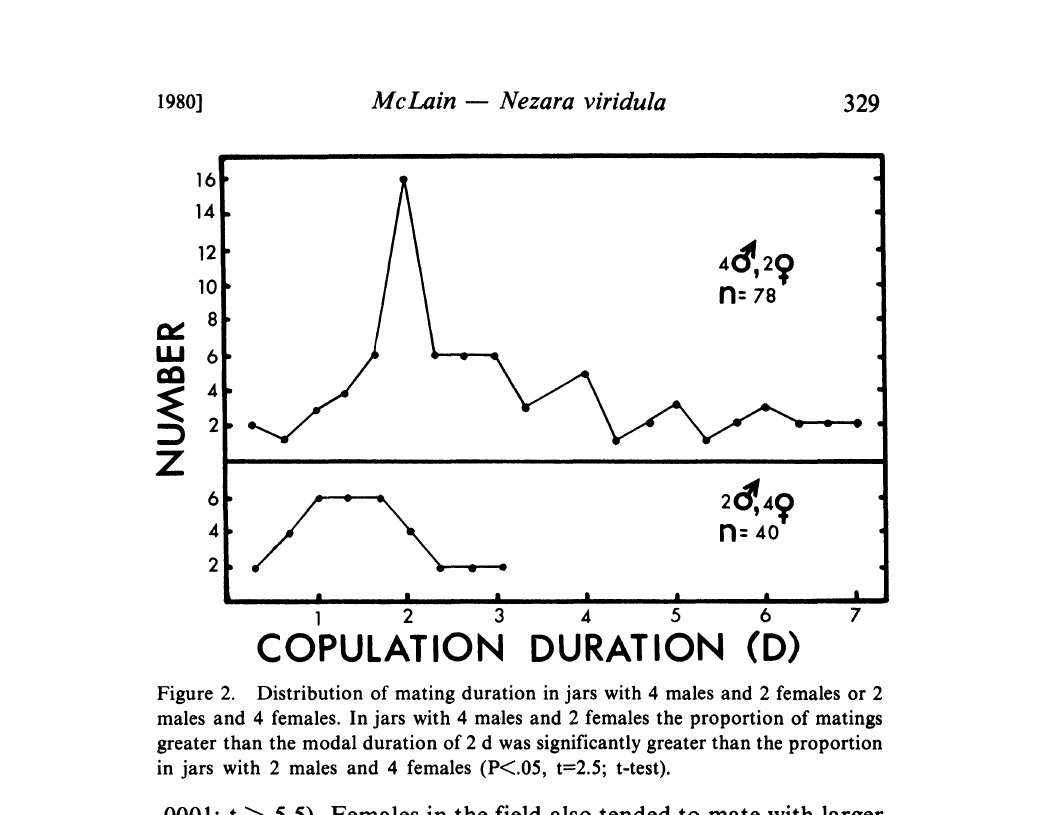
Figure 2. Distribution of mating duration in jars with 4 males and 2 females or 2 males and 4 females. In jars with 4 males and 2 females the proportion of matings greater than the modal duration of 2 d was significantly greater than the proportion in jars with 2 males and 4 females (P<.05, t=2.5;